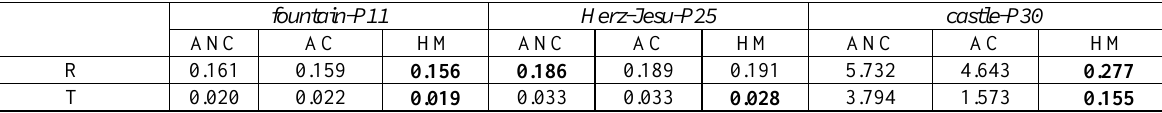
Table 1. Mean angle error R in degree and mean translation error T in meter for different pipelines. We highlight the best results of each dataset.